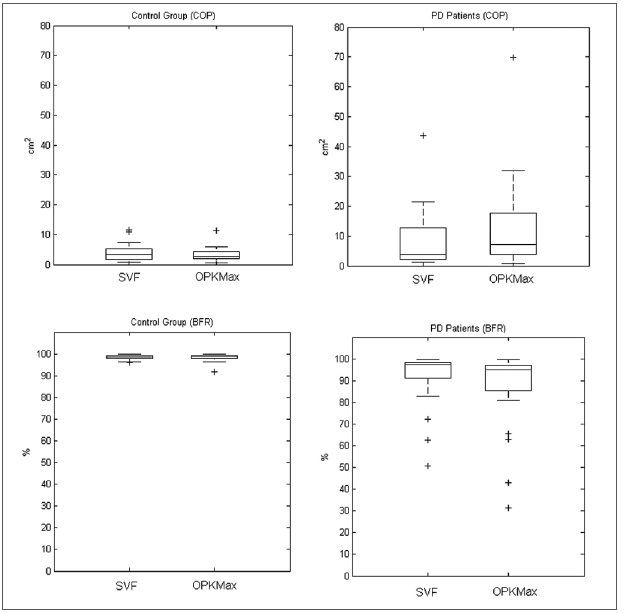
Figure 3. Boxplot comparing results for the COP of the CG between SVF and OK conditions (upper-left), BFR of the CG between both conditions (lower-left), COP of the PD group between both conditions (upper-right) and BFR of the PD group between both conditions (lower-right).